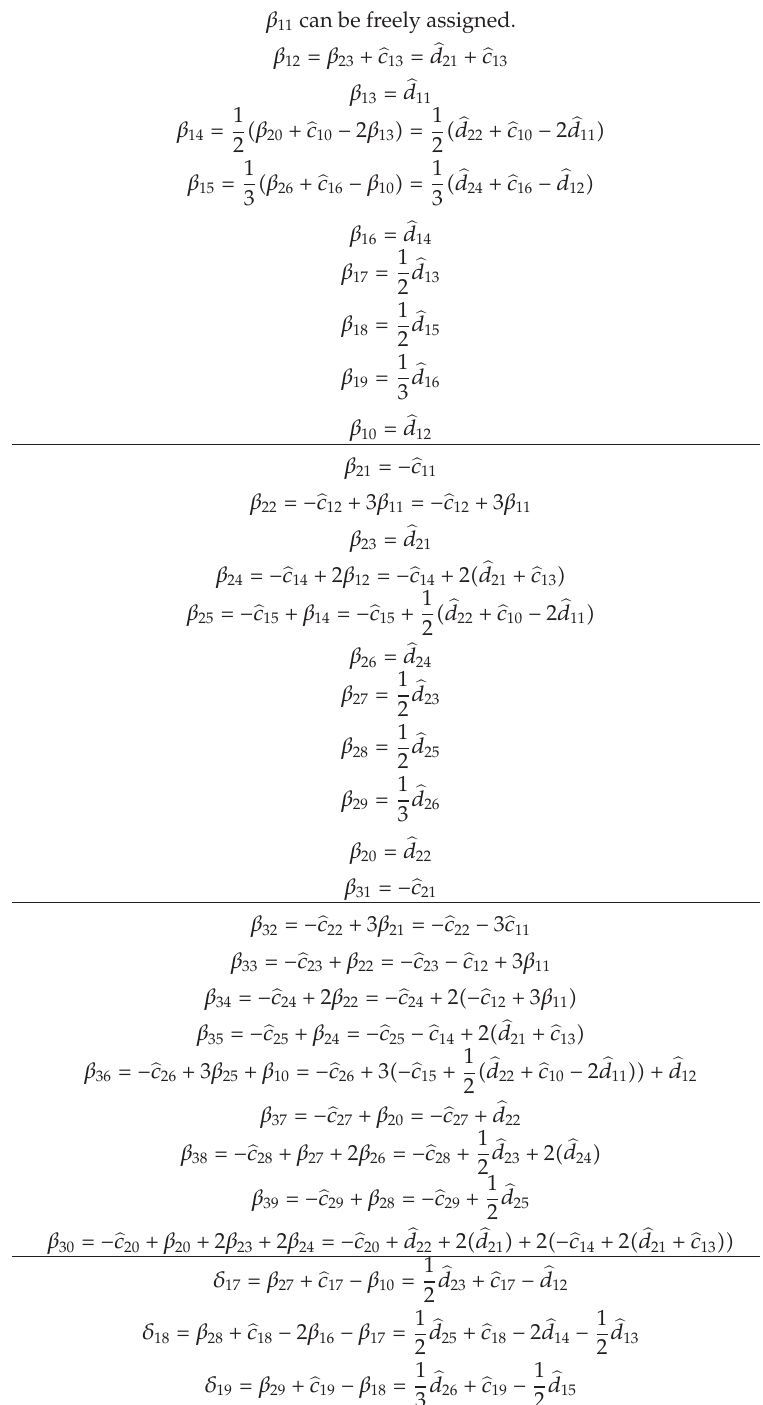
Table 4: Relationships between the coe ffi cients of f (cid:4) 3 (cid:5) (cid:3) z (cid:6) , g (cid:4) 2 (cid:5) (cid:3) z (cid:6) , and ϕ (cid:4) 3 (cid:5) (cid:3) z (cid:6) in (cid:3) A.10 (cid:6) – (cid:3) A.12 (cid:6) , that is, pertaining the cubic part of the nonlinear transformation (cid:3) 3.7 (cid:6) . β 11 can be freely